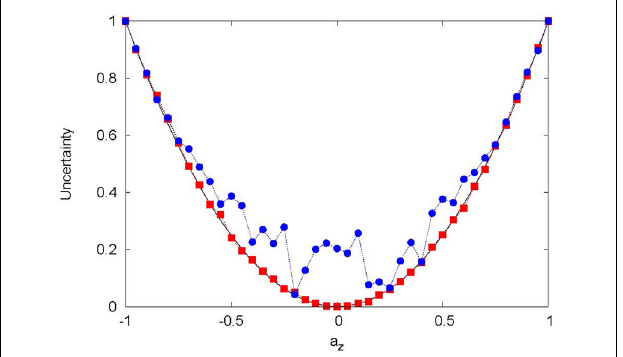
FIGURE 6 | Event-based simulation results for ( 1 − (cid:2) σ x (cid:3) 2 )( 1 − (cid:2) σ y (cid:3) 2 ) (blue circles) and (cid:2) σ z (cid:3) 2 (red squares) for different values of − 1 ≤ a z ≤ 1. The solid black line represents the quantum theoretical lowerbound a 2 z . For each value of a z , the initial direction of the magnetic moments is ( a x , a y , a z ) where ( a x , a y ) is a point on the circle with radius (cid:11) 1 − a 2 z chosen using a uniform pseudo-random number. The fluctuations of the data ( 1 − (cid:4) σ x (cid:5) 2 )( 1 − (cid:4) σ y (cid:5) 2 ) reflect the fact that the initial states with different values of a z are uncorrelated. For each value of a z , N = 10000 messengers were created. The dotted line is a guide to the eyes